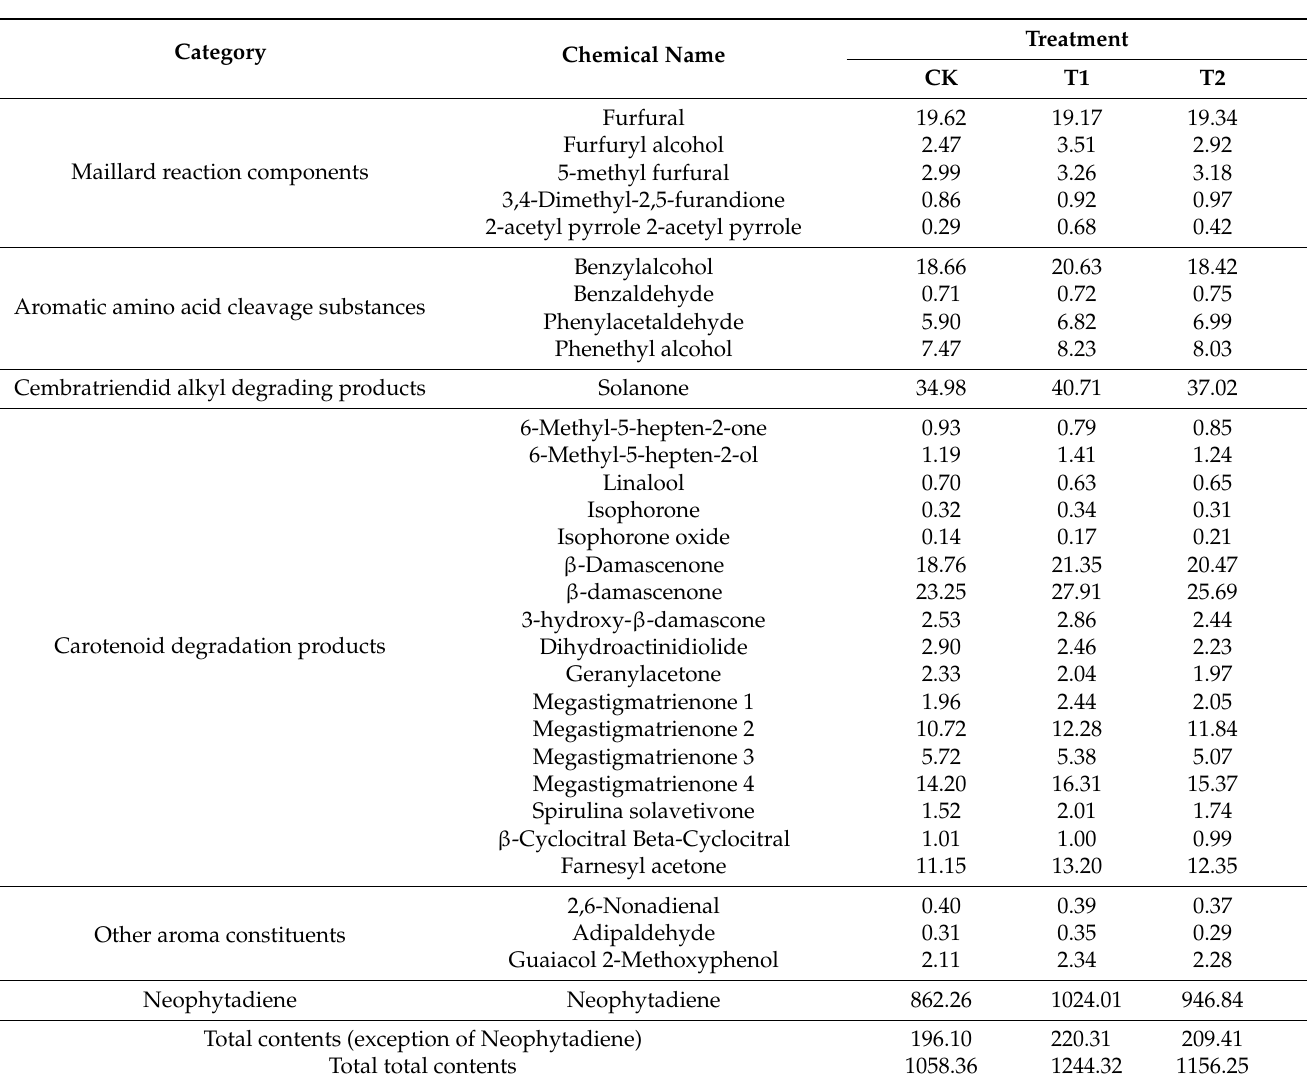
Table 6. Comparison of neutral aroma substances in cured tobacco leaves with different treat- ments ( µ